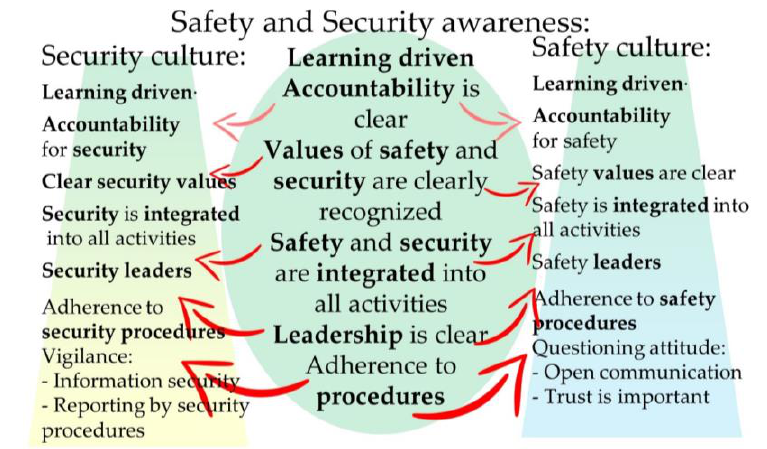
Figure 1: Unique and common elements of safety and security culture model